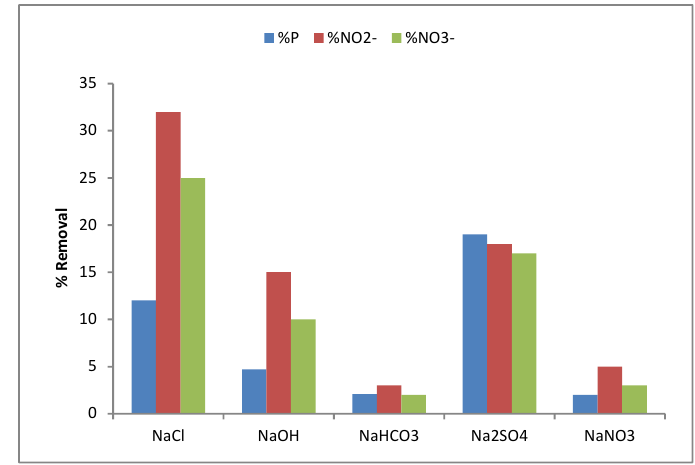
Figure 11. The choice of the counter-ion. Adapted from [109].